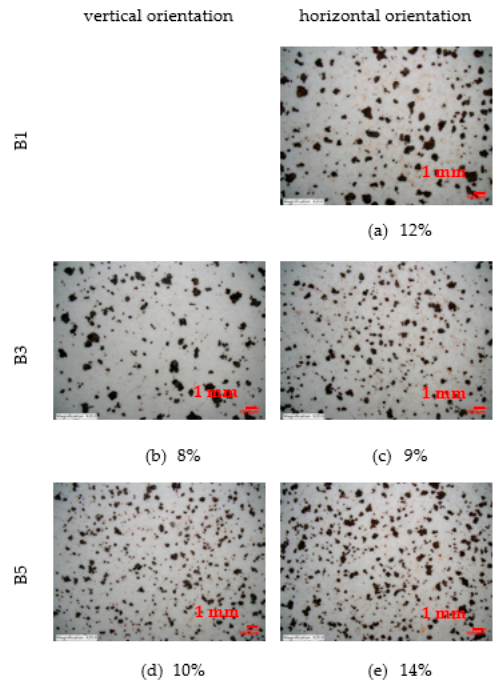
Figure 13. Percentage of marks from Scotch tape test (20× magnification). ( a,c,e ) Percentage of marks from scotch tape test - horizontal orientation of corrosion coupons from stand B1, B3 and B5 ( b,d ) Percentage of marks from scotch tape test - vertical orientation of corrosion coupons from stand B3 and B5.